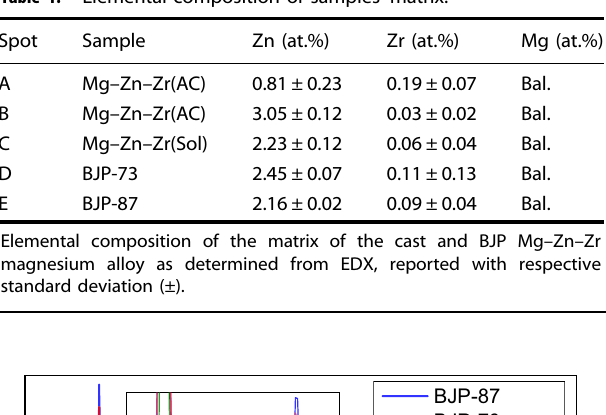
Table 1. Elemental composition of samples ’ matrix. Spot Sample